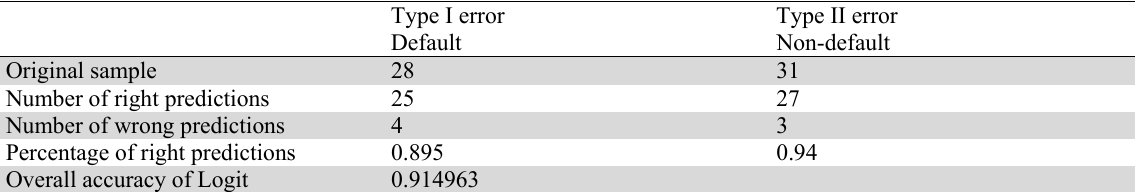
The cost of form I errors and form II